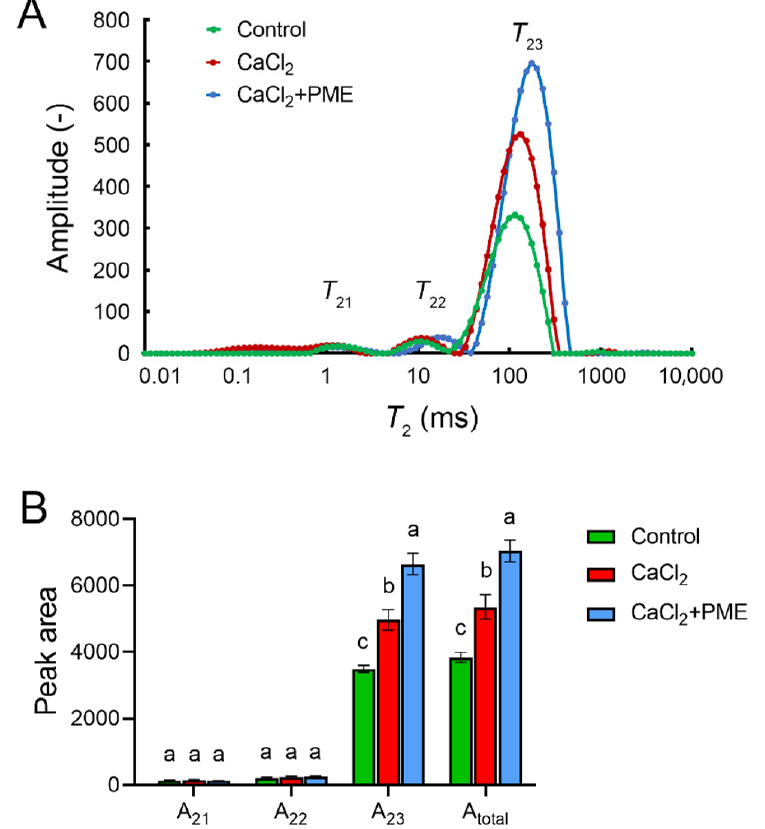
Figure 6. Effects of different treatments on the moisture content of raspberry fruit stored at 4 ◦ C for 9 days. ( A ) low-field nuclear magnetic resonance images, T 21 , T 22 , and T 23 represent bound water, semi-bound water, and free water, respectively; ( B ) the peak area of the corresponding peak of T 21 , T 22 , T 23 and the sum of them all. Vertical bars represent standard deviations of the means. Different lowercase letters indicate the significant differences among the treatments ( p <